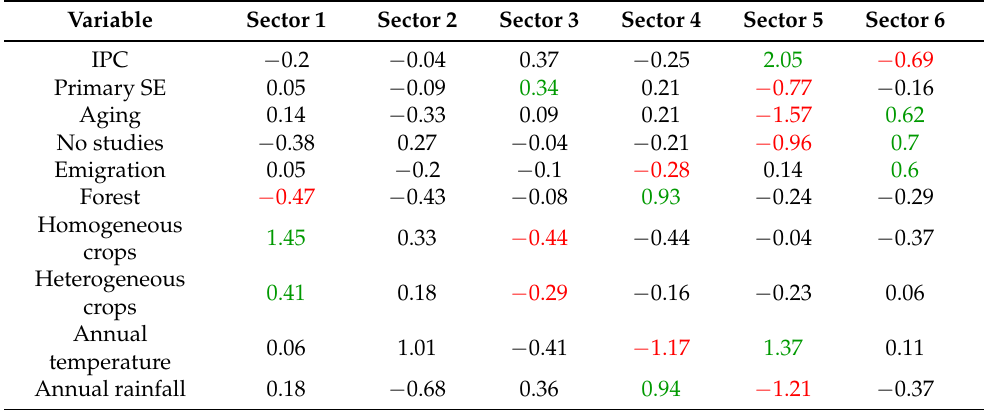
Table 2. Mean standardized scores of some socio-ecological variables by sector. For each variable, the highest mean is shown in green and the lowest in